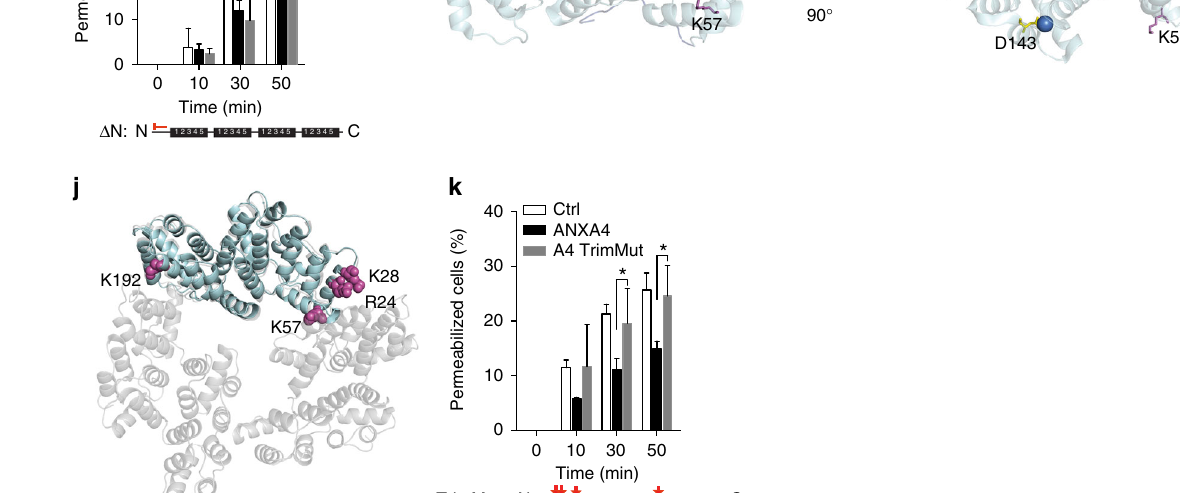
Fig. 1 ANXA4 counteracts plasma membrane injuries triggered by detergent, hypo-osmotic stress, and heat shock. a Immuno fl uorescence images showing endogenous ANXA4 protein localization in HeLa cells (white arrows) exposed to digitonin (20 µ g/ml, 15 min), hypo-osmotic stress (25 mOsm/l, 10 min) or 47 °C heat shock (5 min) (scale bar, 20 µ m). Plasma membrane integrity assays in cells overexpressing ANXA4-RFP or Ctrl-RFP and b treated with digitonin (20 µ g/ml) in HeLa cells, or c MCF7 cells exposed to hypo-osmotic stress (25 mOsm/l) and assayed with impermeable Hoechst-33258. Also, see Supplementary Fig. 1. d Images showing FM1-43 dye uptake in MCF7 cells exposed to hypo-osmotic stress and e corresponding intensity plot. f Plasma membrane integrity upon 55 °C heat shock in MCF7 cells expressing ANXA4 wild type, or g Ca 2+ -binding-de fi cient mutants, h mutant lacking N terminus (aa 4-13) ( Δ N). i Residues mutated in the Ca2Mut/Ca4Mut and the TrimMut ANXA4 mutants are indicated with yellow and pink sticks, respectively, on the crystal structure of ANXA4 (PDB entry code: 2zoc) displayed in transparent light blue cartoon with bound calcium ions as blue spheres. j ANXA4 (light blue) is structurally aligned on a subunit of homotrimer observed in the crystal structure of ANXA5 (transparent gray, PDB entry code: 1a8a) and the residues mutated in the ANXA4- TrimMut mutant displayed as pink spheres. The two structures are aligned to a root-mean-square deviation (RMSD) value of 0.942 Å over 302 C α atoms (PyMOL Molecular Graphics System, Version 1.7.6.4, Schrödinger, LLC). k Membrane integrity upon 55 °C heat shock in MCF7 cells expressing ANXA4-TrimMut as compared to wtANXA4 and control. Means of three independent experiments measuring > 40 cells for each condition. Error bars represent S.D. for three independent experiments. P values based on t -test: * P ≤ 0.05, ** P ≤ 0.01, *** P ≤ 0.001